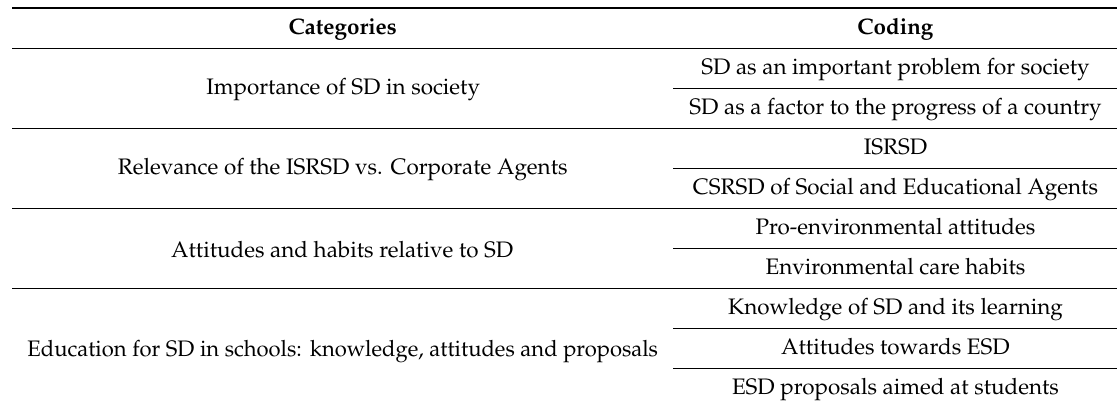
Table 1. Categorisation system and